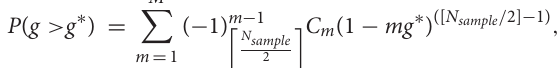
Frontiers in Systems Neuroscience |